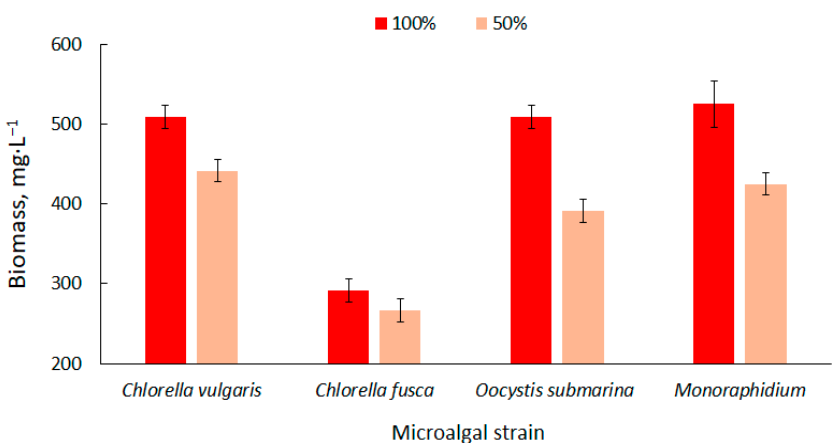
Figure 1. Dynamics of biomass content changes of four strains in relation to nutrient supply in the culture medium . culture